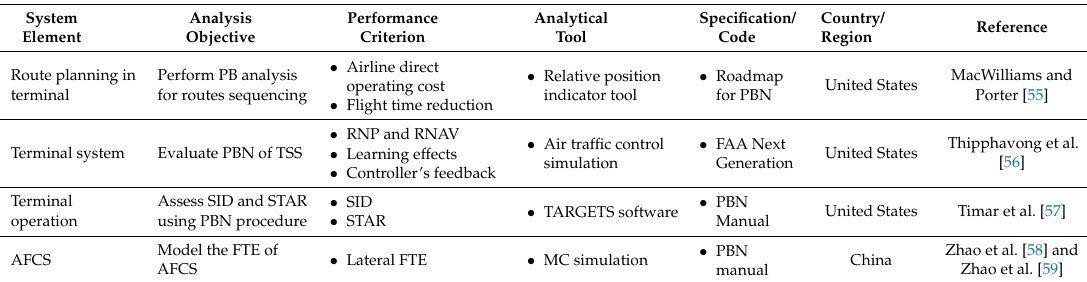
Table A3. Characteristics of air transportation applications.